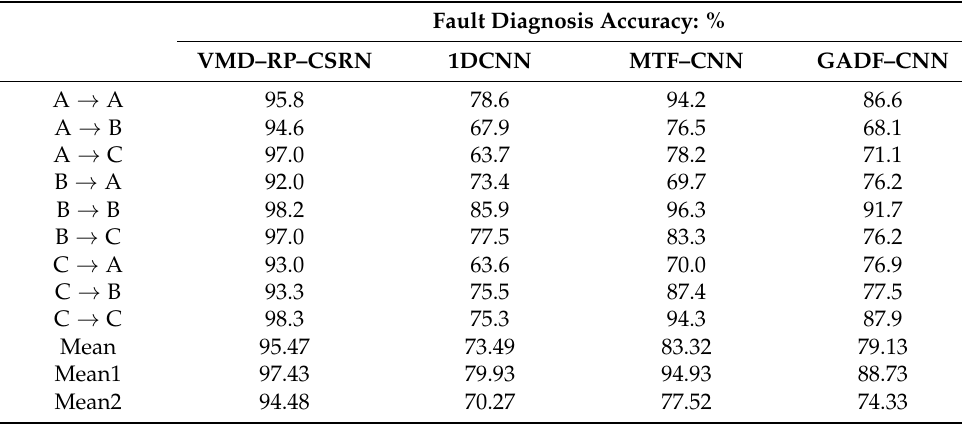
Table 4. Experimental results of model diagnosis at 50% training set